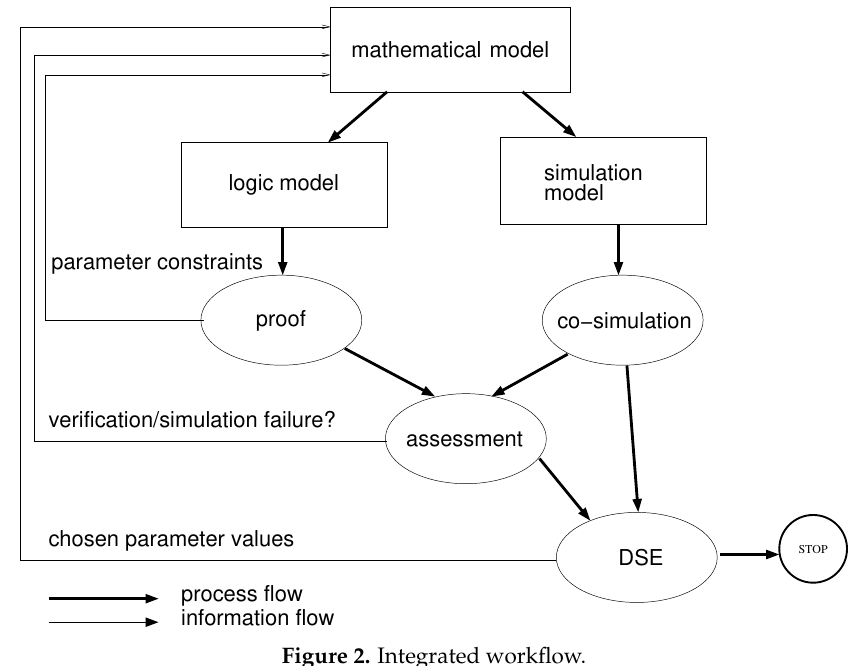
Figure 2. Integrated